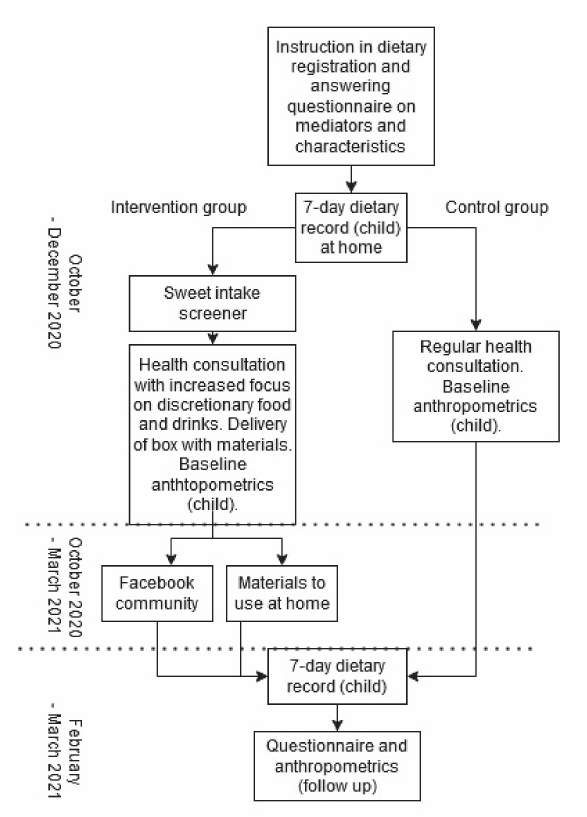
Figure 1. Study flow of the “Are you too Sweet?”